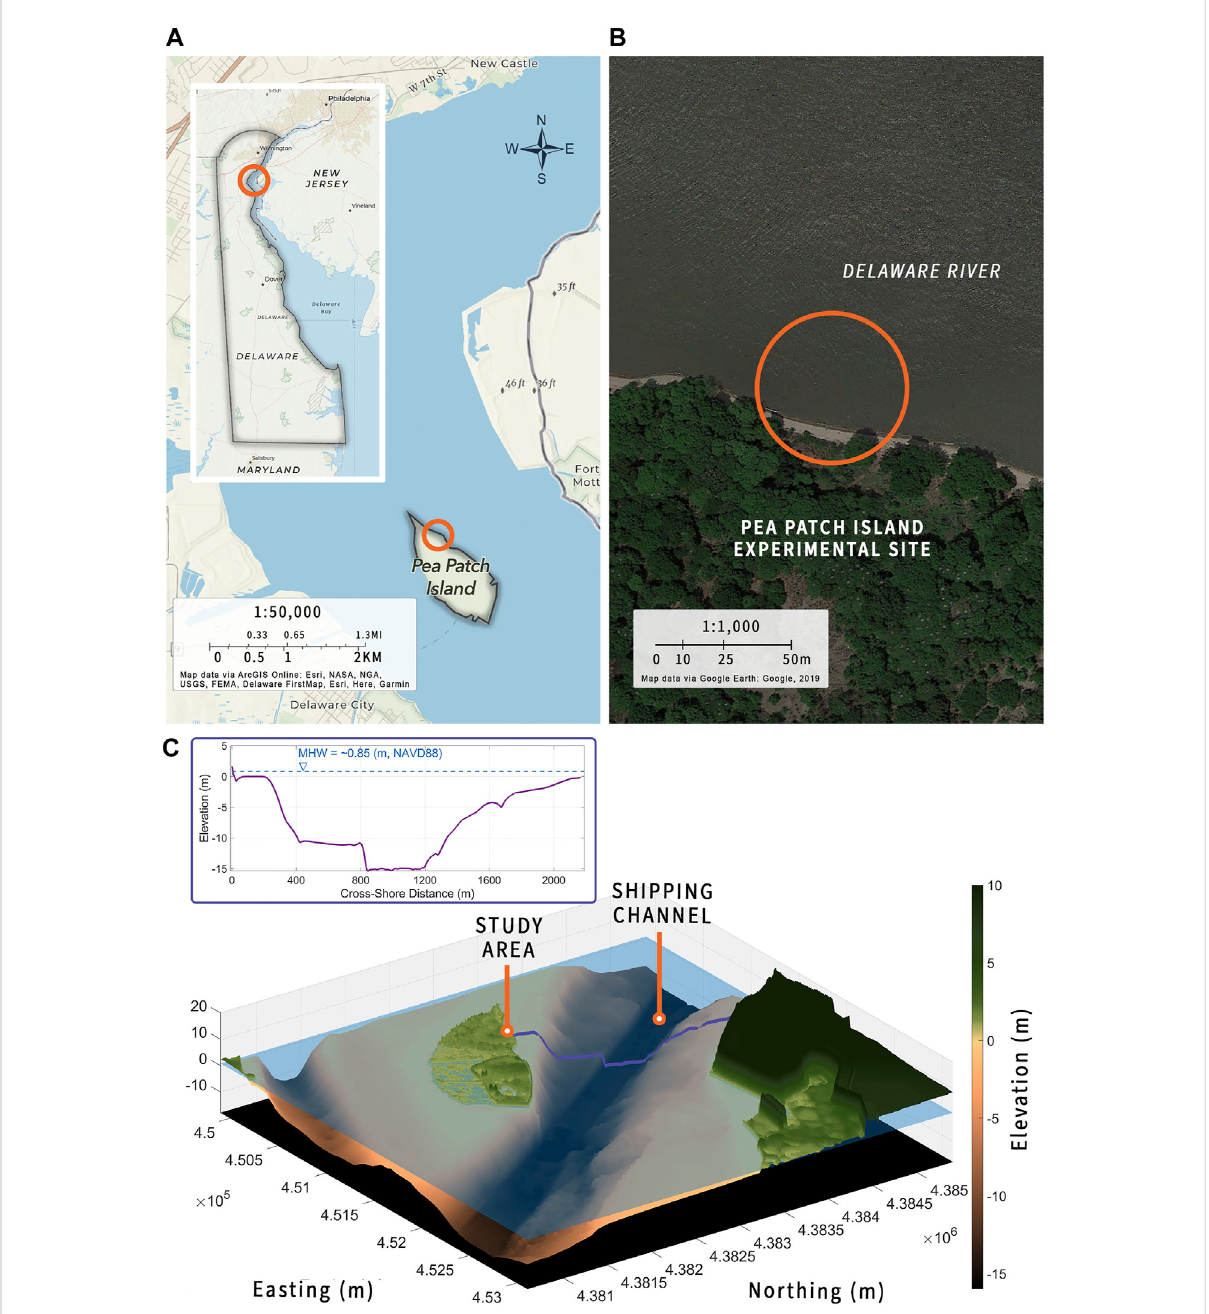
FIGURE 1 (A) Location of Pea Patch Island in the Delaware River. (B) Area of living shoreline and fi eld instrumentation deployment. (C) Bathymetry in the shipping channel surrounding Pea Patch Island The subplot indicates the elevation of the cross-shore transect from the study site through the shipping